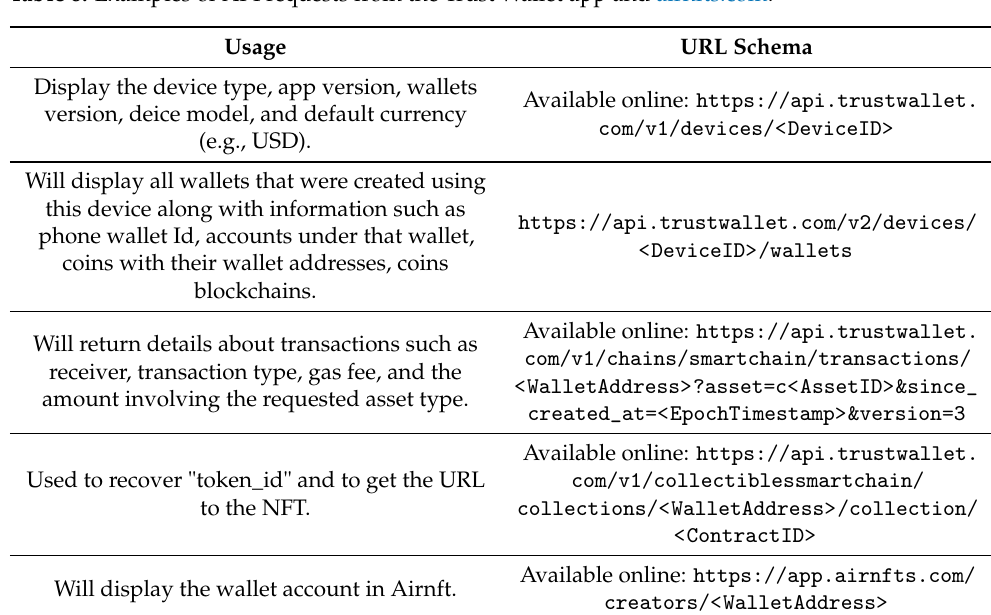
Figure 37. Recovered Wallet addresses for the Metamask app in iOS. Table 8. Examples of API requests from the Trust Wallet app and